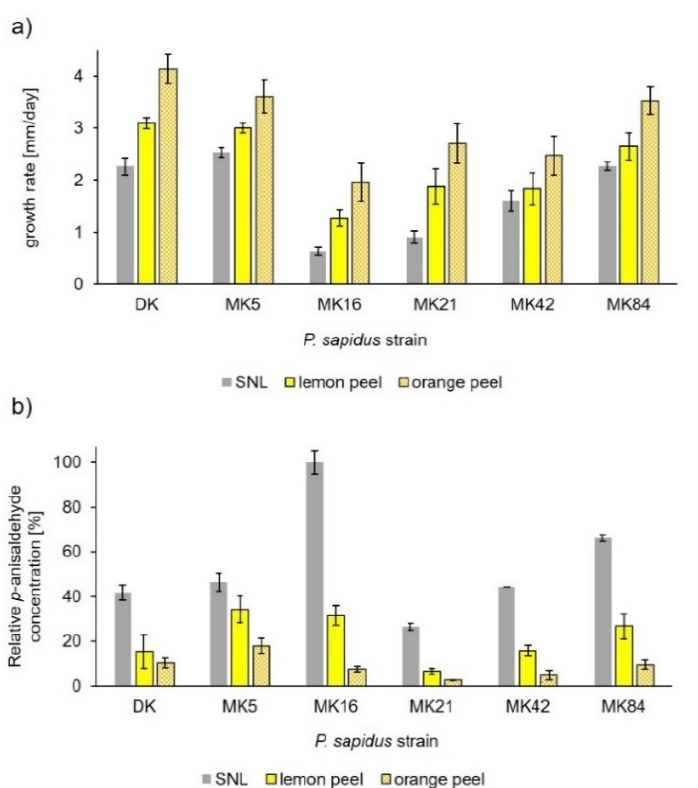
Figure 3. Influence of different cultivation media on the growth rate and alkene cleavage activity of P. sapidus . ( a ) Radial growth rate on agar plates. ( b ) Enzymatically generated concentration of p -anisaldehyde after cleavage of trans -anethole using finely ground lyophilized mycelium. Concentrations were calculated relative to the highest p -anisaldehyde concentration. Lemon peel: MM supplemented with 5% lemon peel ( w / v ), orange peel: MM supplemented with 5% orange peel. DK—dikaryon, MK—monokarya [60].